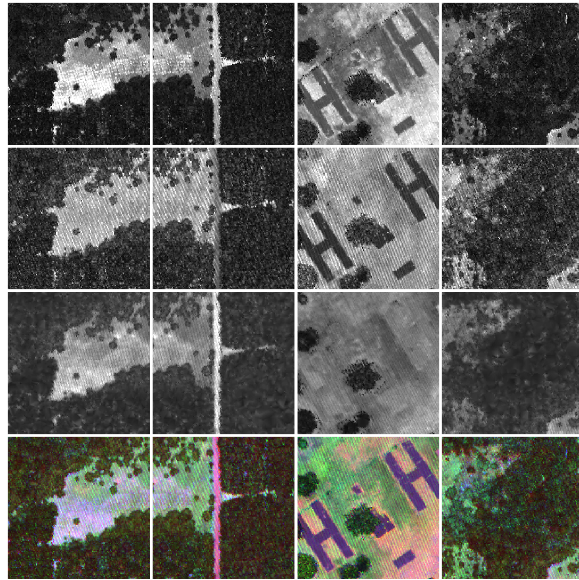
Figure 2. Experimental multispectral LiDAR data (from left to right: grass cover, road, roof top, tree top; from top to bottom: channel 1 (1550 nm), channel 2 (1064 nm), channel 3 (532 nm) and the multispectral airborne LiDAR